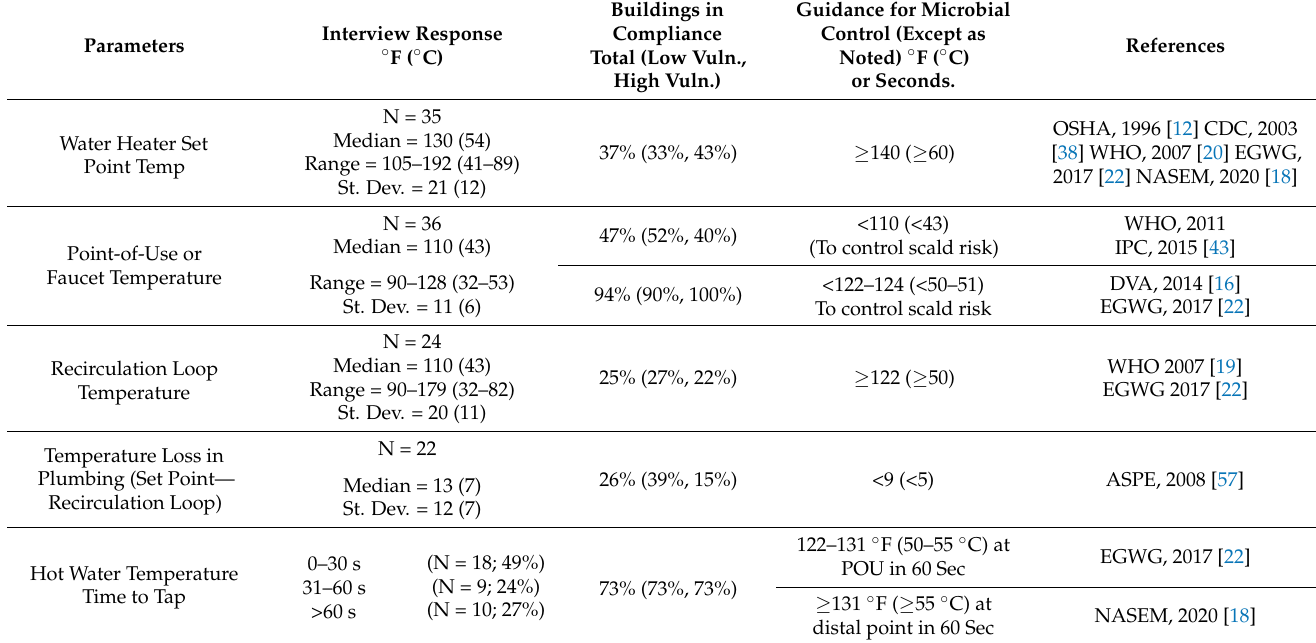
Table 4. Summary statistics of the temperatures recorded during interviews at different locations in premise